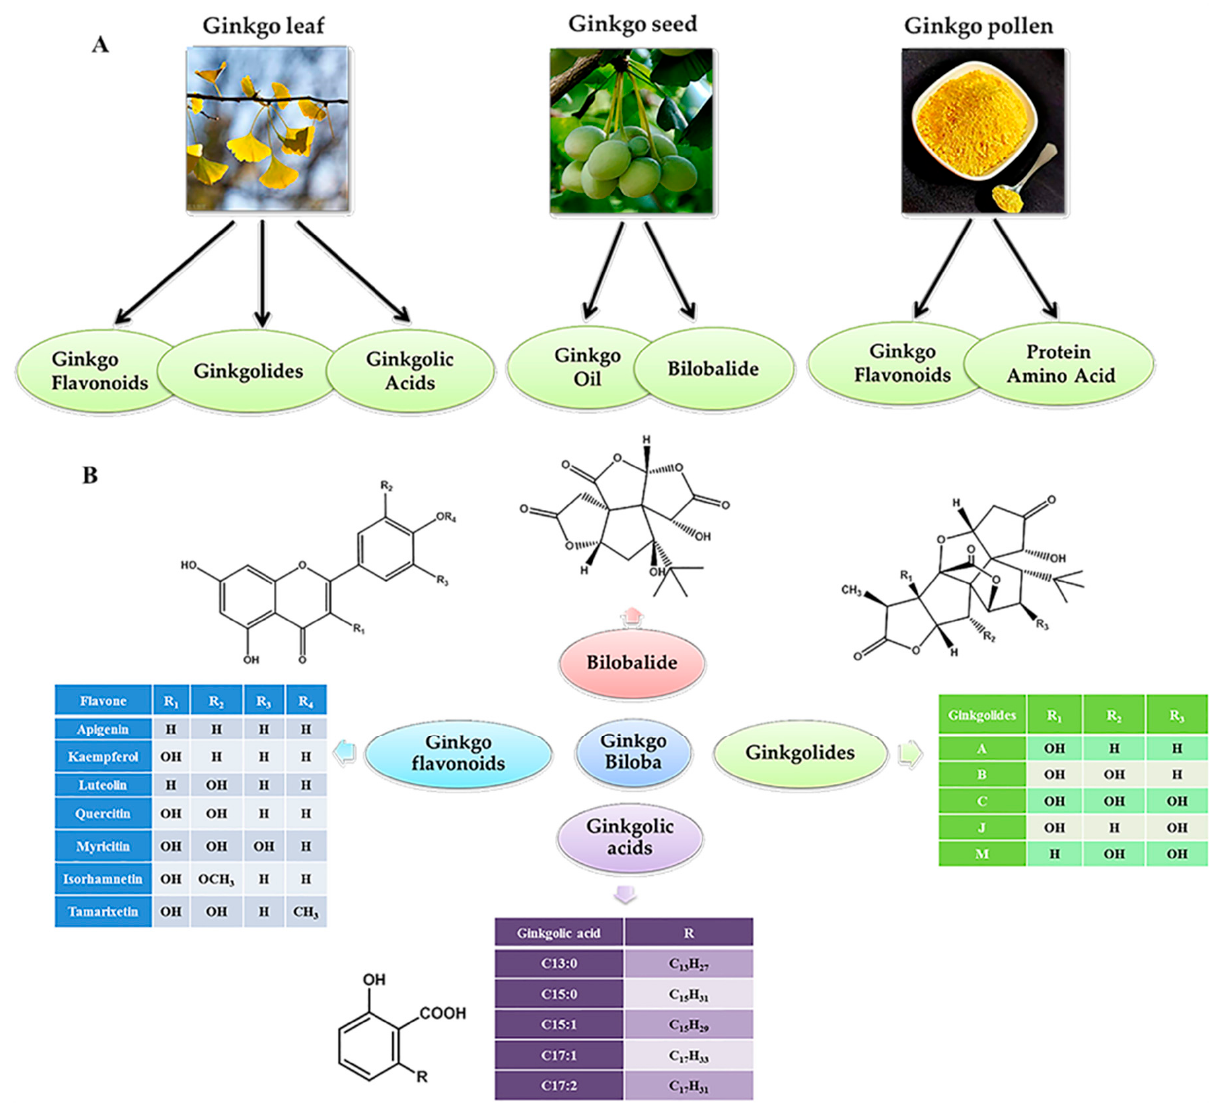
Figure 2. The active components ( A ) and related structures ( B ) in Ginkgo biloba L. 2-phenylchromone and no substitution of oxygen-containing groups at the 3-position [36]. Ginkgo flavonoids usually have substituents at the 3-position of the C ring, 3 (cid:48)